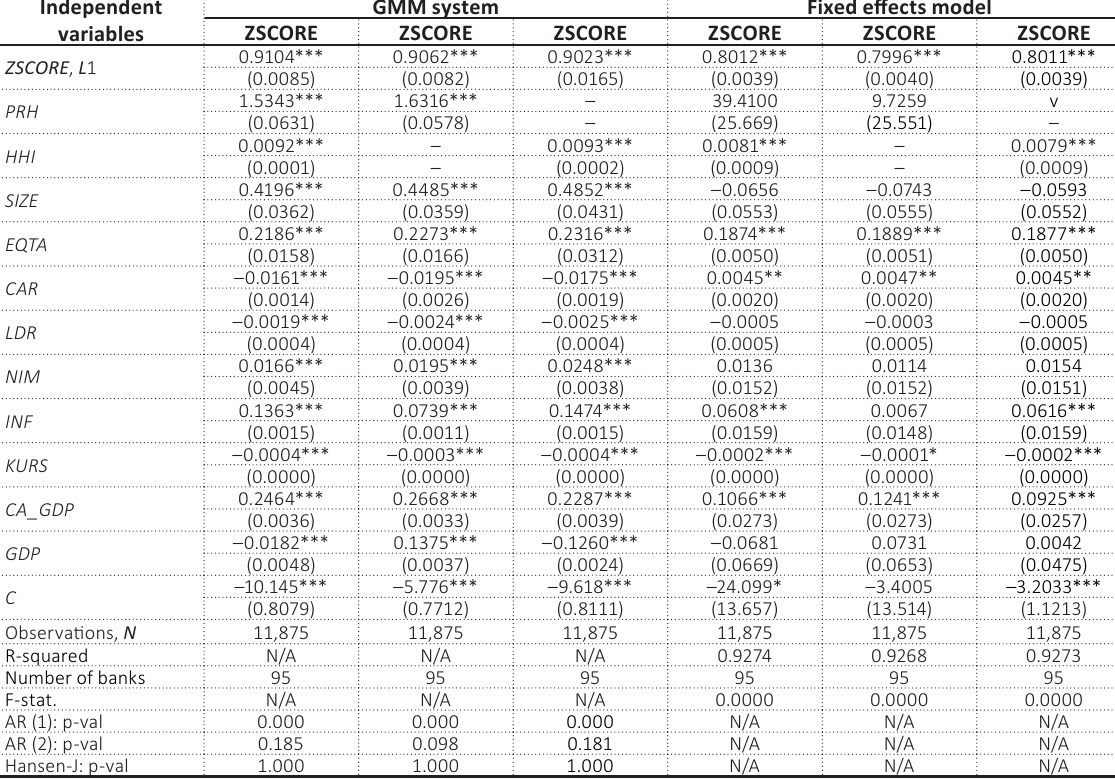
Table 4. Impact of bank competition ( PRH or HHI ) on the risk of banking stability ( ZSCORE )